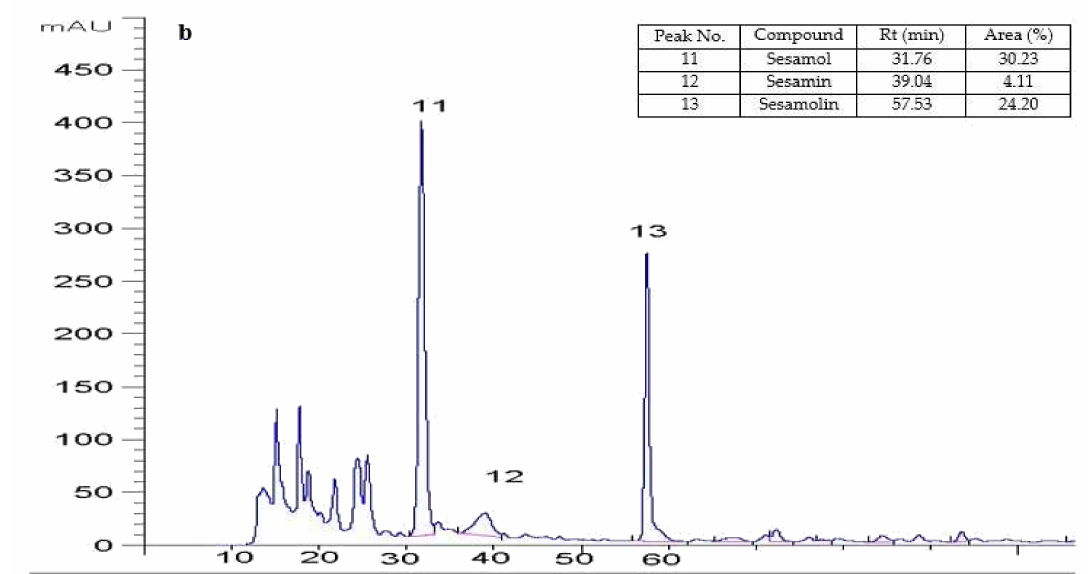
Figure 1. ( a ) HPLC fingerprints of LSSCE were identified as gallic acid (peak 1), coffeic acid (peak 2), syringic acid (peak 3), coumaric acid (peak 4), ferulic acid (peak 5), naringenin (peak 6), propyl gallate (peak 7), p-hydroxybenzoic (peak 8), querectin (peak 9), and cinnamic acid (peak 10); ( b ) HPLC fingerprints of lignins in LSSCE were identified as sesamol, (peak 11), sesamin (peak 12), and sesamolin (peak